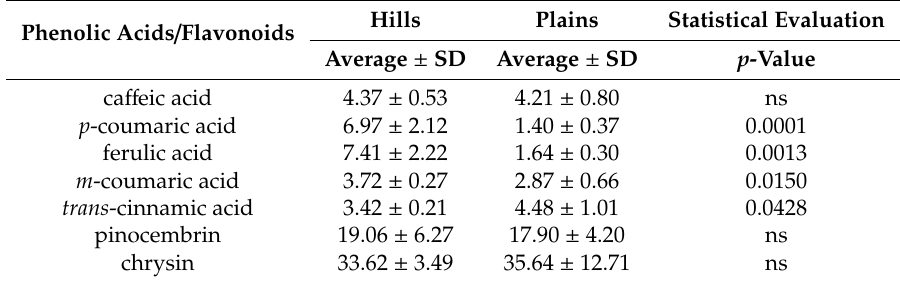
Table 2. The content of phenolic acids / flavonoids (mg / g) evaluated by HPLC-UV in alcoholic extract of propolis samples from hills (Ligurian–Piedmont Apennines) and plains (Po